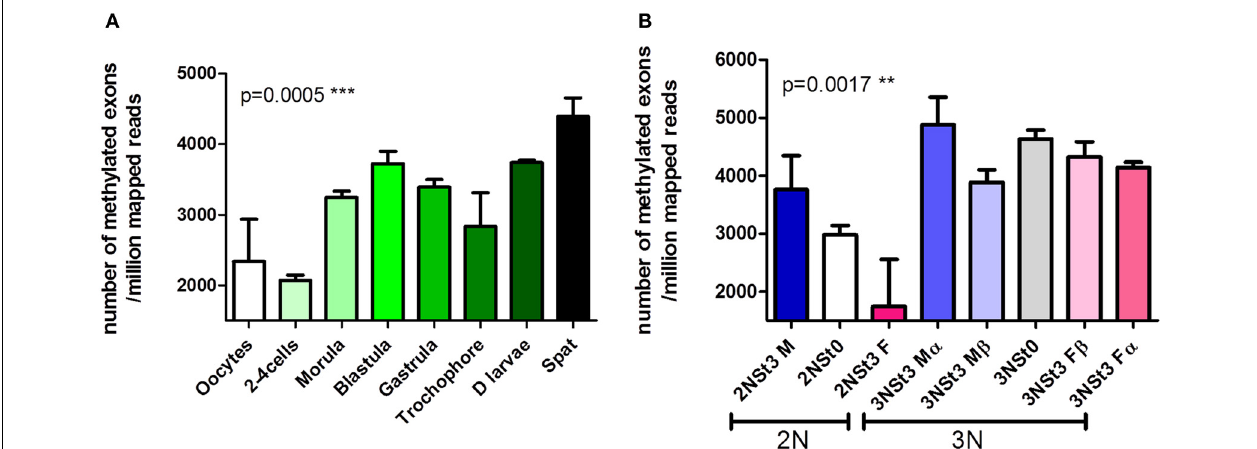
FIGURE 2 | Dynamic changes in the exome-wide methylation pattern during the oyster development (A) and gametogenesis (B). Exon mapping after MeDIP-seq at the different stages indicated. Values are given as the mean ± s.e.m. of triplicate experiments. P values are given for One-Way ANOVA ( p < 0 . 05 was considered